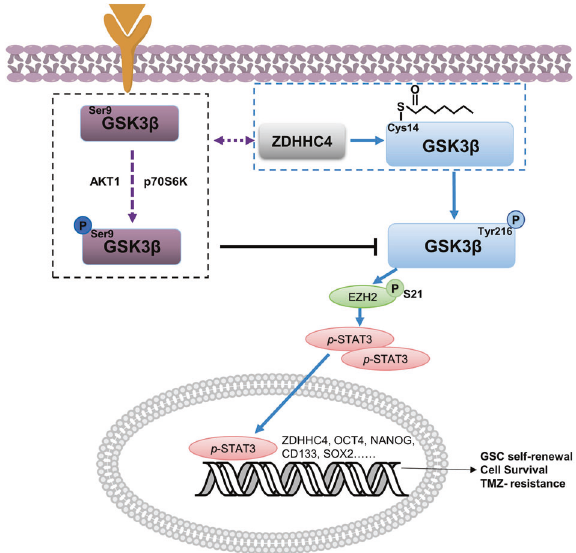
Fig. 7 Schematic showing that ZDHHC4-mediated GSK3 β palmi- toylation promotes GBM TMZ-resistance. ZDHHC4 palmitoylates GSK3 β and competitively binds GSK3 β with AKT and p70S6K kinases, which inhibits GSK3 β Ser9 phosphorylation and enhances GSK3 β Tyr216 phosphorylation. Activated GSK3 β enhances GSC self- renewal, GBM TMZ-resistance, and tumorigenesis by promoting the EZH2/STAT3